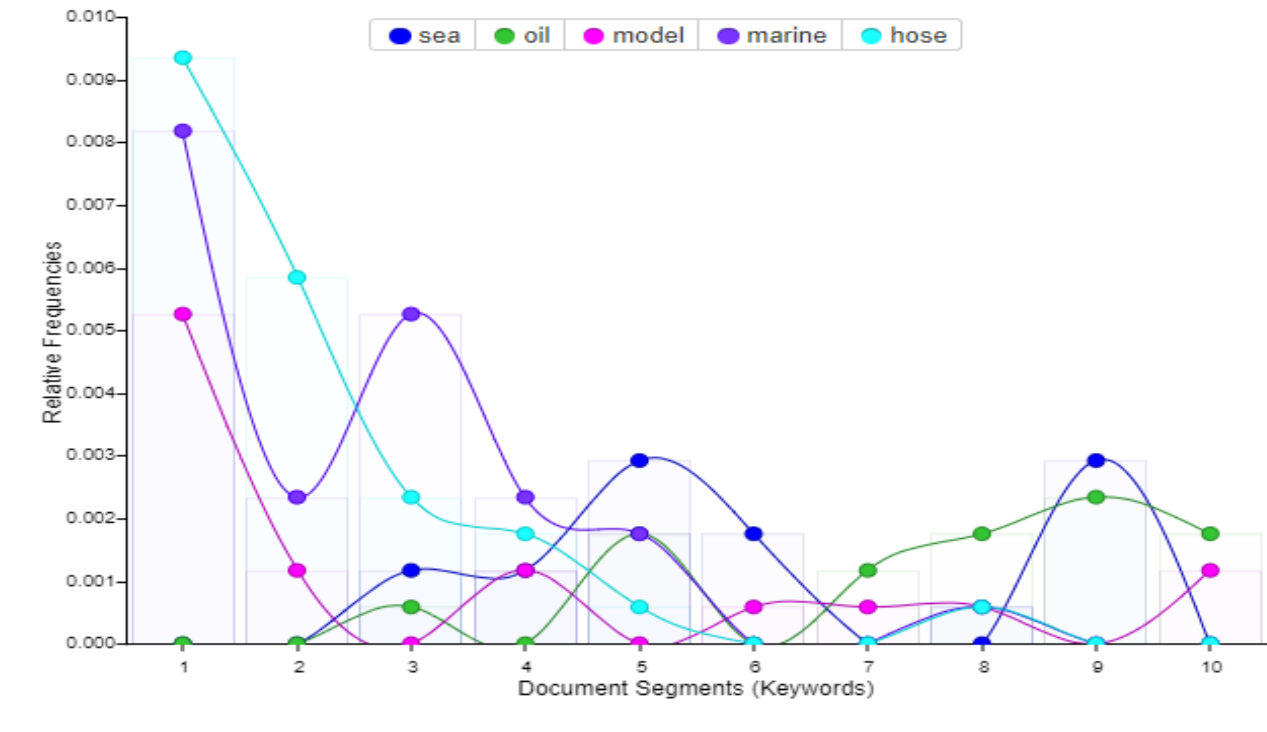
Figure 7. Result of relative frequency and trend from the most frequent author keywords on “marine hose” generated using Voyant tools.